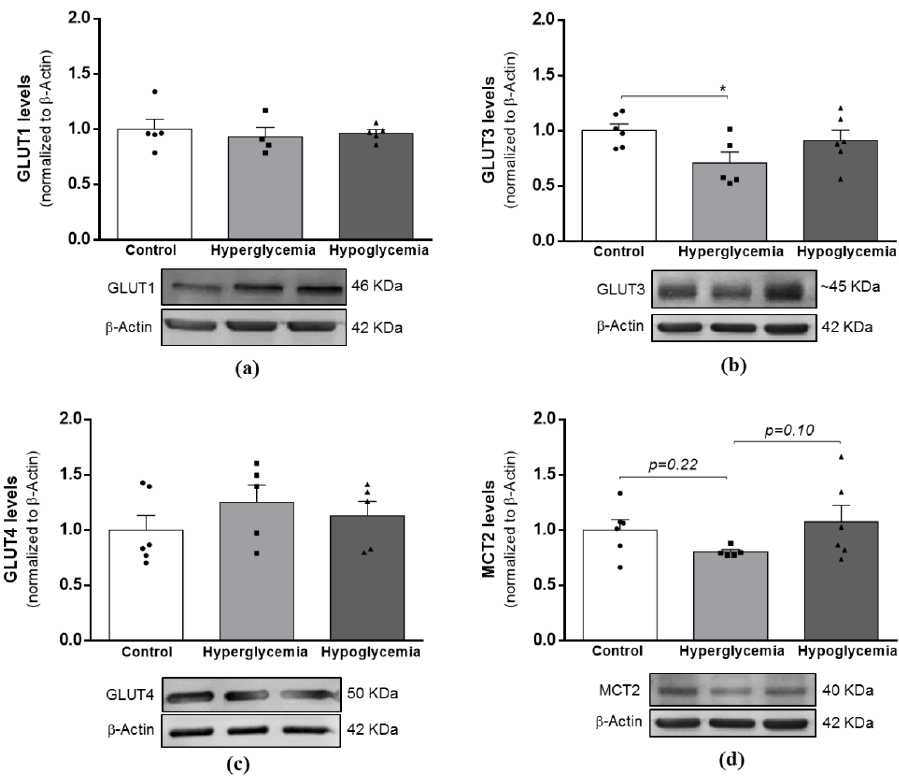
Figure 1. Effects of long-term hyperglycemia and insulin-induced recurrent hypoglycemia in the expression levels of brain glucose and monocarboxylate transporters. Western blot analyses of ( a ) GLUT1, ( b ) GLUT3, ( c ) GLUT4 and ( d ) MTC2 protein levels after normalization with β -Actin. Bars in graphs represent the mean ± SEM of the quantification of brain cortical samples from 4–6 rats under each condition. Representative immunoblots for β -actin are shown as loading control (for uncropped images of the Western blots, please see Supplementary Data). A * p < 0.05 was consid- ered as a statistically significant difference. GLUT—Glucose transporter; MCT2—Monocarboxylate transporter